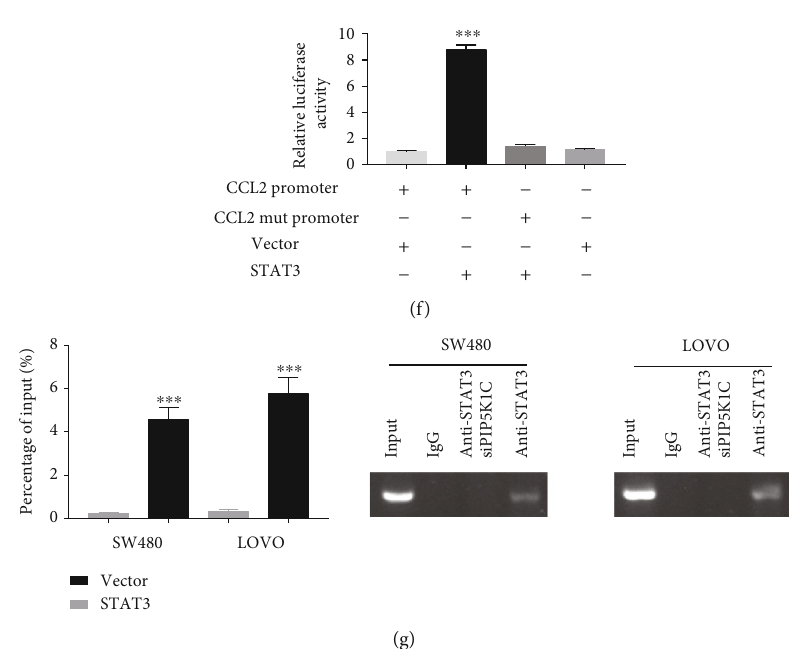
Figure 3: STAT3 transcriptionally regulates PIP5I γ to increase CCL2 expression. (a) Stable PIPKI γ -expressing HCT116 and SW620 cells were transfected with siP65, siSTAT3, siSTAT1, siTwist1, or siETS1 for 48h, and the CCL2 mRNA level was measured by quantitative PCR with reverse transcription. (b) CCL2 mRNA expression levels were detected in stable PIPKI γ -expressing HCT116 and SW620 cells treated with JSH-23 and Stattic in FBS-free medium. (c) Stable PIPKI γ -expressing HCT116 and SW620 cells were transfected with si p65 and siSTAT3 for 48h, and the CCL2 protein level was measured by ELISA. (d) CCL2 protein expression levels were detected in stable PIPKI γ -expressing HCT116 and SW620 cells treated with JSH-23 and Stattic in FBS-free medium. (e) The predicted STAT3 binding site on the upstream 0-2000bp and the STAT3 binding motif. HEK 293 cells were transiently cotransfected with luciferase reporter plasmid (pGL3) containing the CCL2 DNA promoter region [-2000/0]) or di ff erent promoter fragment constructs, Renilla, vector, or STAT3 as indicated. After 30 h, luciferase activities were determined by dual luciferase assay. Luciferase activities were normalized to Renilla luciferase activities. The values indicated represent normalized luciferase activities and are shown as the mean ± S : E : from triplicate assays. (f) Luciferase assay for HEK 293 cells transiently cotransfected with luciferase reporter plasmid (pGL3) containing the CCL2 DNA promoter region [-2000/0]) or motif mutant constructs, Renilla, vector, or STAT3 as indicated. (g) ChIP-PCR analysis of STAT3 binding to the CCL2 promoter in the presence or absence of PIPKI γ silencing in SW480 and LOVO